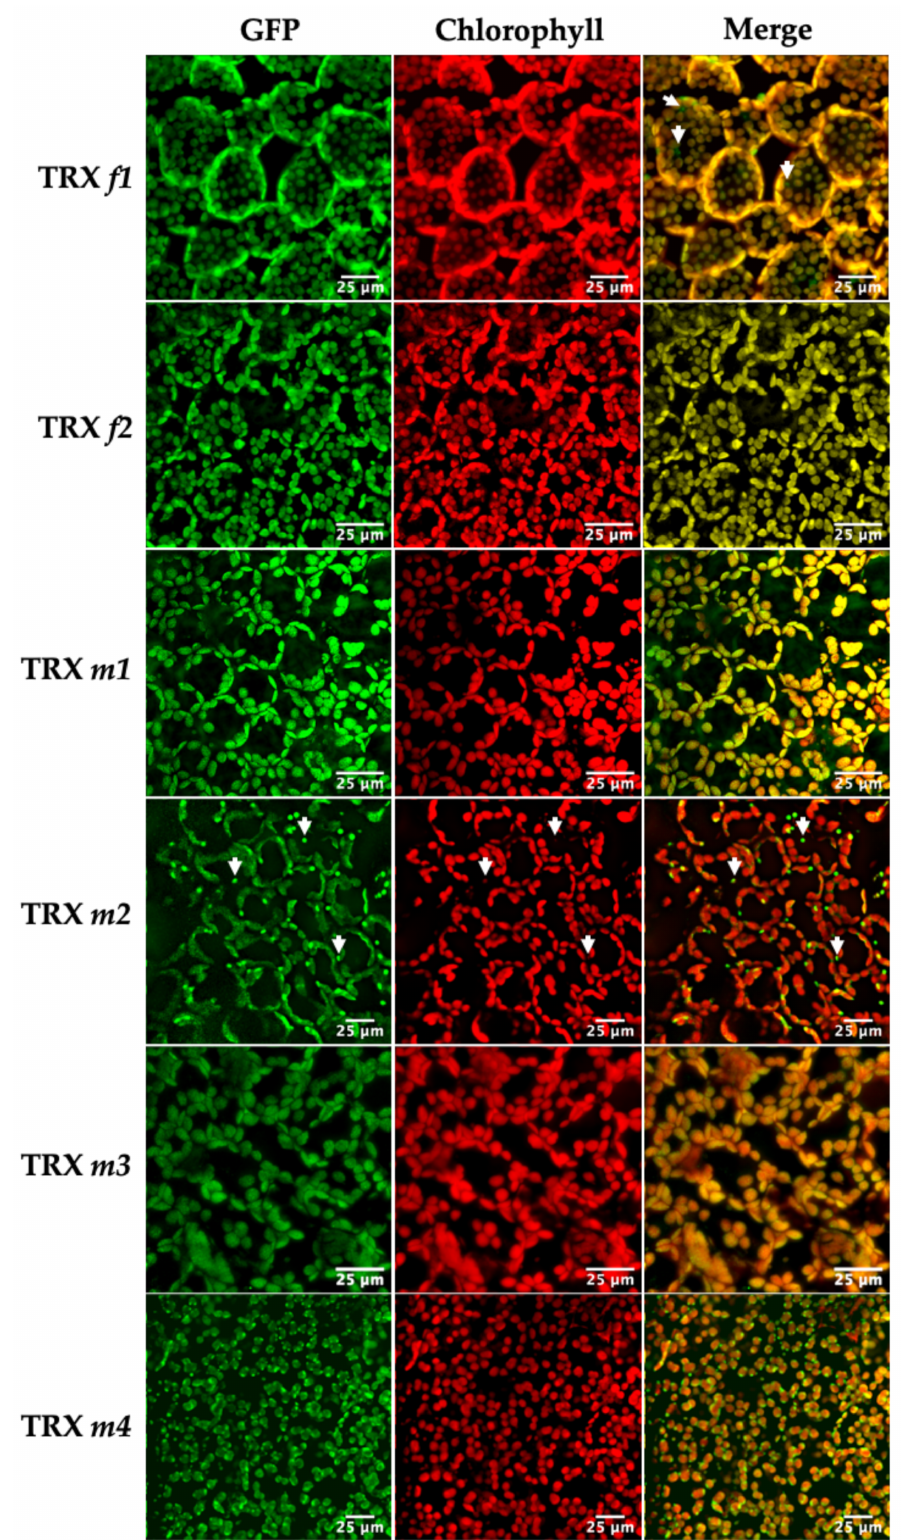
Figure 1. Representative confocal images of Arabidopsis lines expressing the TRX( f/m )::GFP constructs in the cotyledon mesophyll of 7-day-old Arabidopsis seedlings. GFP, fusion protein fluorescence; Chlorophyll, chlorophyll autofluorescence; Merge, the computer overlay of the two fluorescence images. Arrows highlight some peculiar sub-cellular localisations (explained in